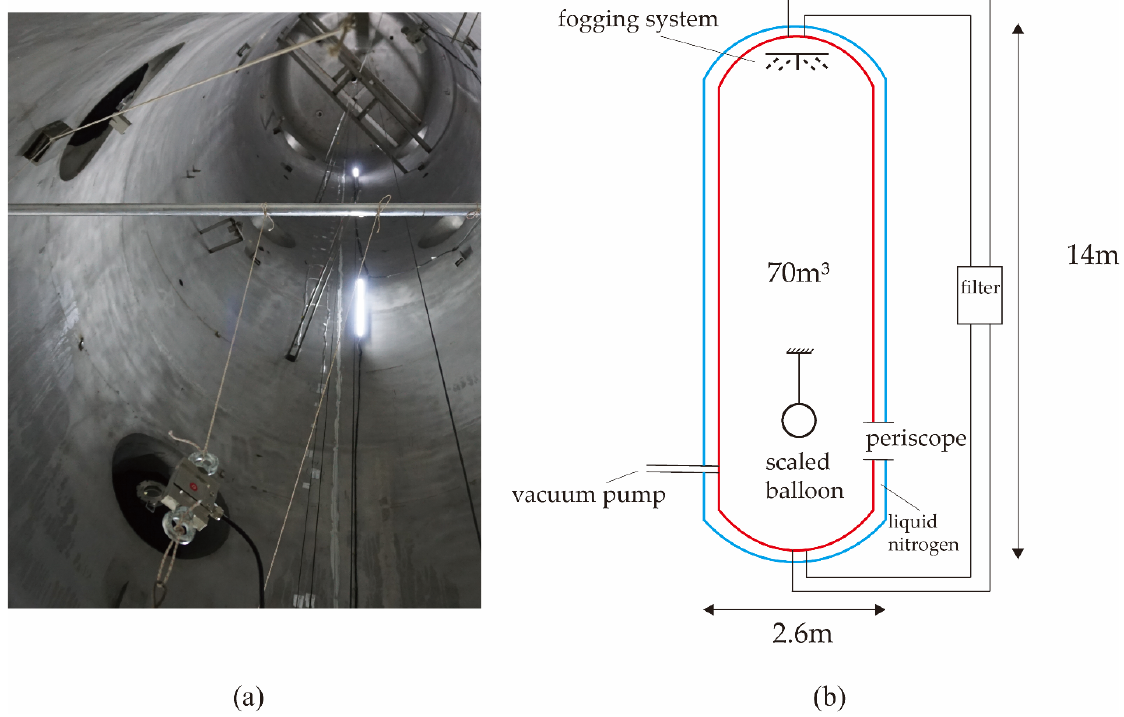
Figure 2. ( a )Practical setup ( b )Diagram of experimental apparatus design. Figure 2. ( a ) Practical setup ( b ) Diagram of experimental apparatus